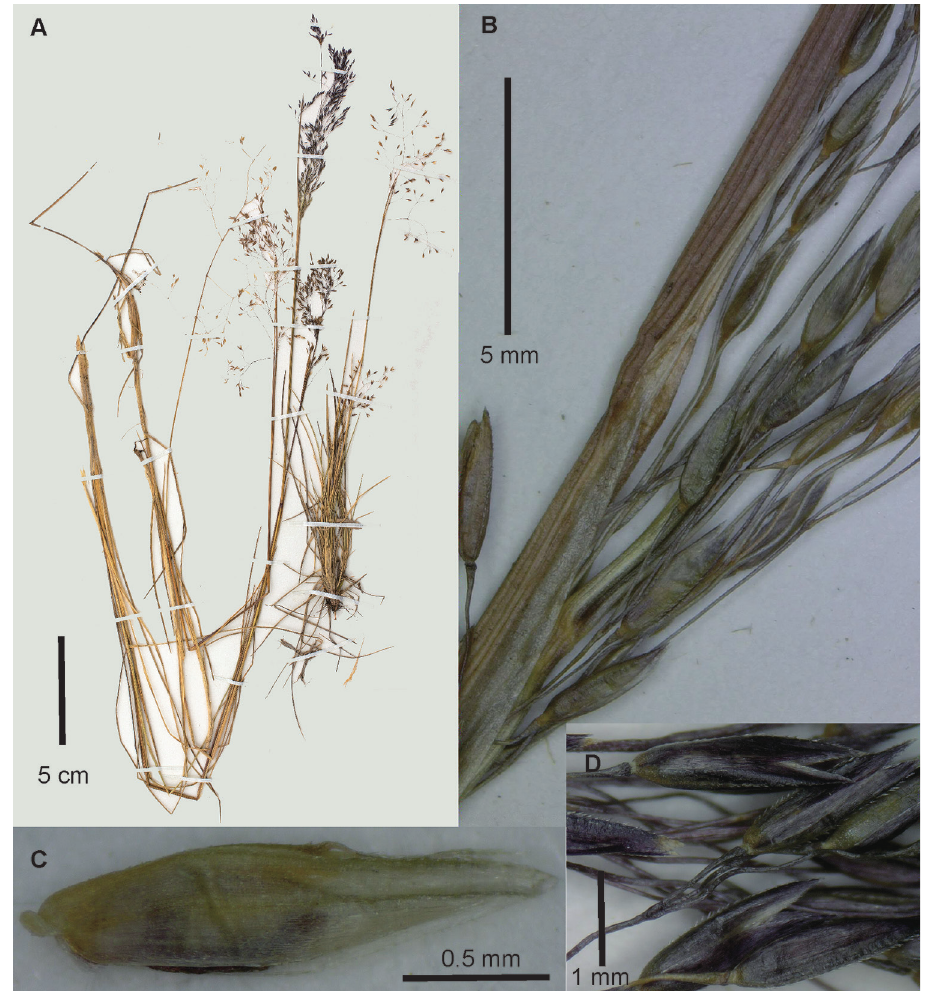
Figure 6. Agrostis cf. imberbis A whole plant B flag ligule and portion of inflorescence C floret, lateral view D portion of inflorescence with close-up of spikelets. Images of Cleef 6821 (US2785719), courtesy of United States National Herbarium